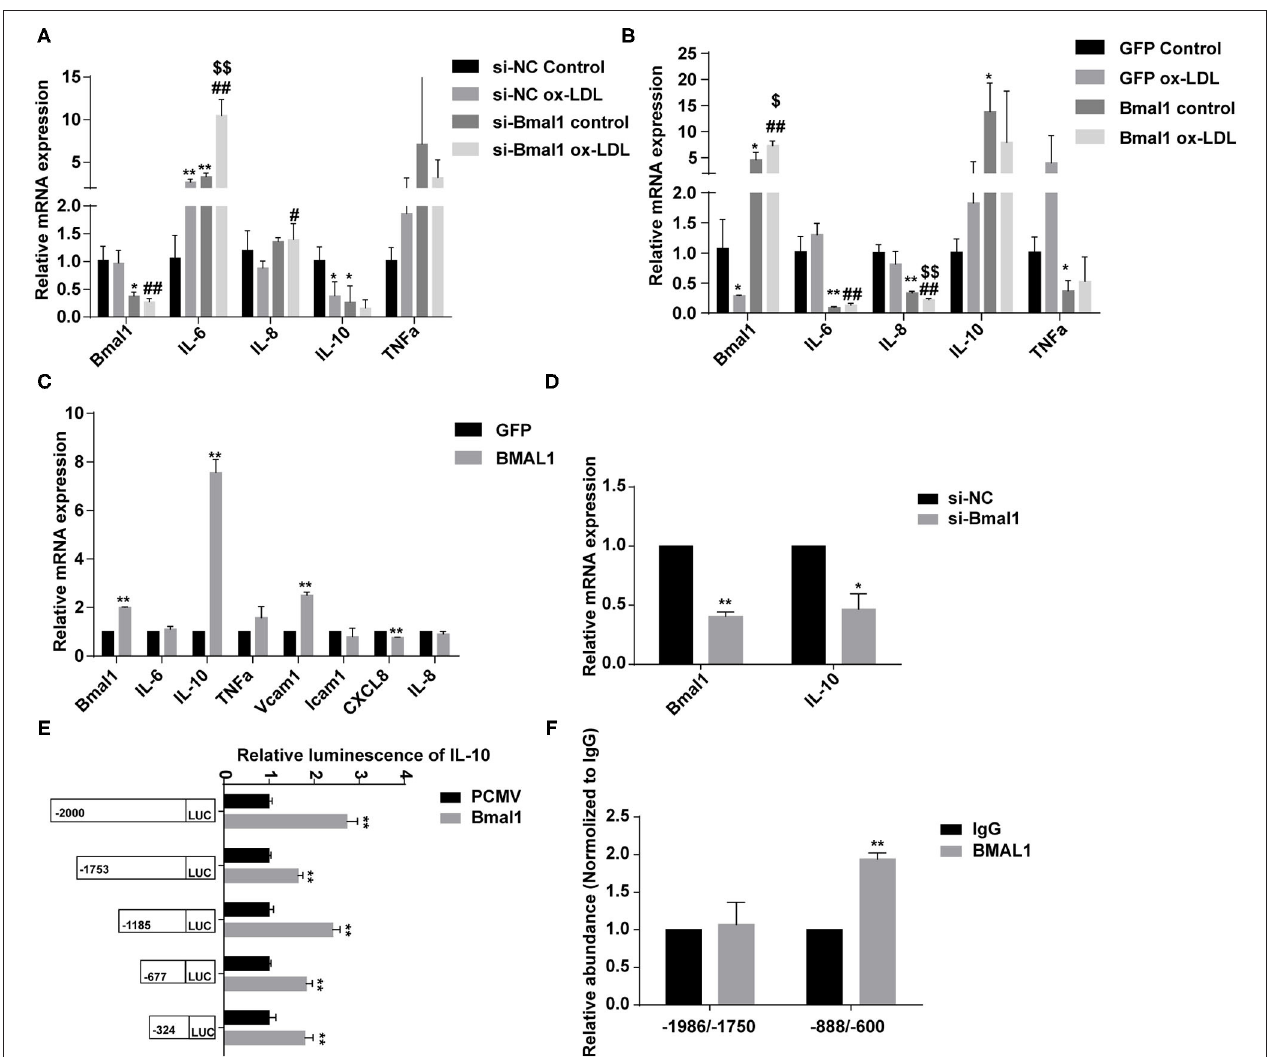
FIGURE 3 | Bmal1 represses inflammation by inhibiting the lipid uptake and transcriptionally regulating the IL-10 expression. (A) Relative mRNA expression of genes involved in inflammation in human umbilical vein endothelial cells (HUVECs) which had been transfected with si-NC or si-Bmal1 with or without the addition of ox-LDL. Data are presented as mean ± SEM (one-way ANOVA with post-hoc Tukey test). * p < 0.05 and ** p < 0.01 vs. si-NC control; # p < 0.05 and ## p < 0.01 vs. si-NC ox-LDL; $$ p < 0.01 vs. si-Bmal1 control. (B) Relative mRNA expression of genes involved in inflammation in HUVECs which had been transfected with adenoviruses coding for AdGFP or AdBmal1 with or without the addition of ox-LDL. Data are presented as mean ± SEM (one-way ANOVA with post-hoc Tukey test). * p < 0.05 and ** p < 0.01 vs. GFP control; ## p < 0.01 vs. GFP ox-LDL; $ p < 0.05 and $$ p < 0.01 vs. Bmal1 control. (C) Relative mRNA expression of genes involved in inflammation in HUVECs which had been transfected with adenoviruses coding for AdGFP or AdBmal1. Data are presented as mean ± SEM (unpaired t -test). ** p < 0.01 Bmal1 vs. GFP. (D) Relative mRNA expression of Bmal1 and IL-10 in HUVECs which had been transfected with Bmal1 siRNA or si-NC. Data are presented as mean ± SEM (unpaired t -test). * p < 0.05 and ** p < 0.01 si-Bmal1 vs. si-NC. (E) Luciferase reporter constructs were created containing the truncated ( − 2,000, − 1,753, − 1,185, − 677, and − 324) versions of the IL-10 promoter. The luciferase reporter constructs were co-transfected with Bmal1 overexpression vector or with the control vector into HEK293T cells, and luciferase activity was evaluated 24h later. Data are presented as mean ± SEM (unpaired t -test). ** p < 0.01 Bmal1 vs. PCMV. (F) ChIP assay conducted in HUVECs with anti-BMAL1 or IgG antibody. qRT-PCR analysis was performed with primer sequences around Bmal1-binding E-box elements in the IL-10 promoter. Data are presented as mean ± SEM (unpaired t -test). ** p < 0.01 BMAL1 vs. IgG. Each expreiment was repeated 3 independent